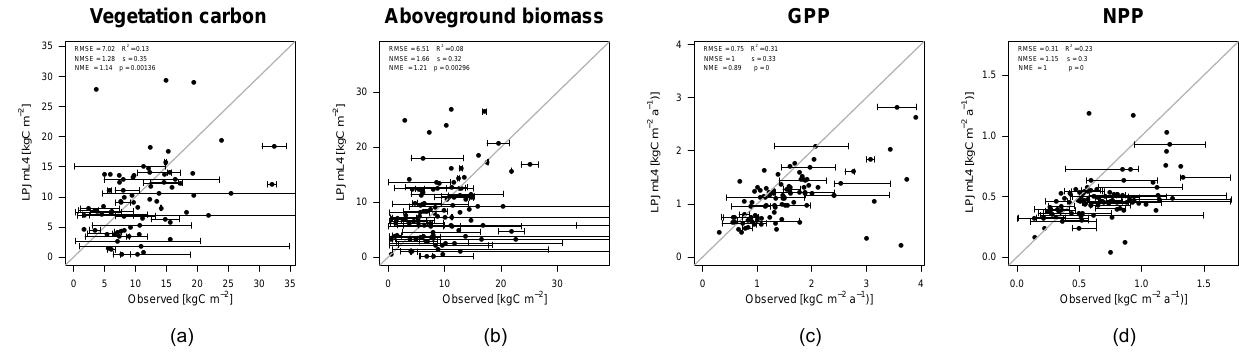
Figure 4. Evaluation of vegetation carbon (a) , aboveground biomass (b) , GPP (c) , and NPP (d) . Observed data are provided by Luyssaert et al. (2007). Bars give the minimum and maximum of the estimation within one 0.5 ◦ cell simulated by LPJmL4.